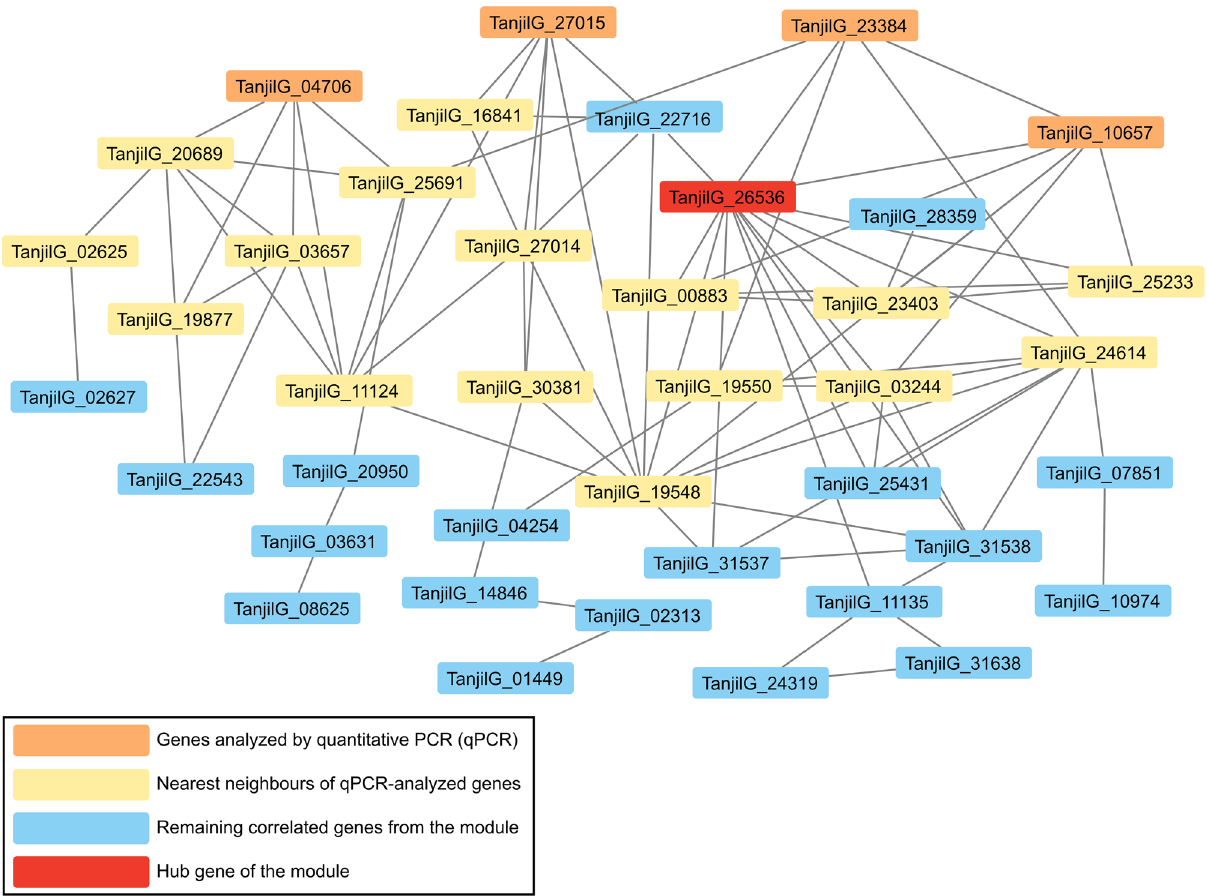
Figure 8. Weighted gene co-expression network analysis for a module with overrepresented biological process term “GO:0006952 defense response”. The connections are simplified to highlight four genes analyzed by quantitative PCR ( TanjilG_04706 , TanjilG_23384 , TanjilG_10657 and TanjilG_27015